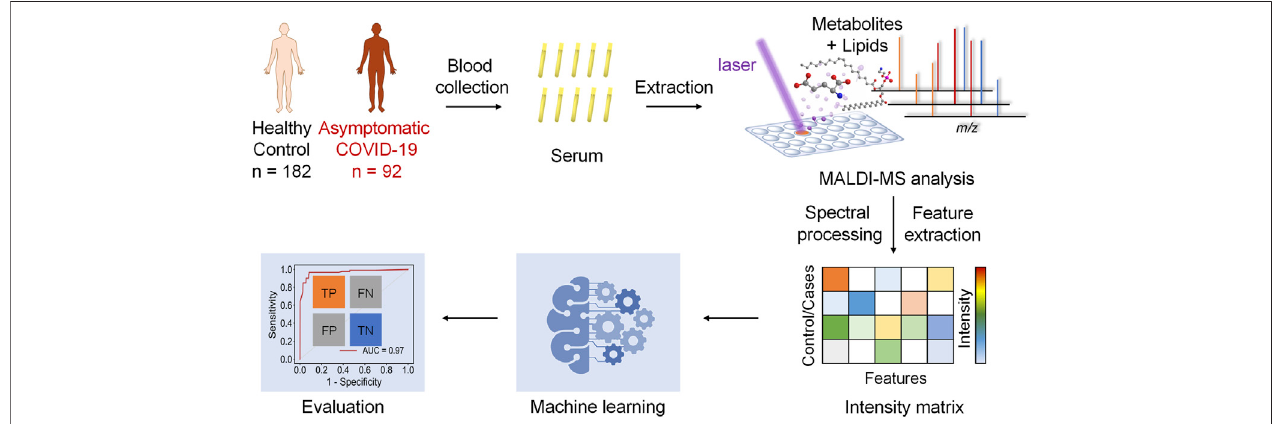
FIGURE 1 | Schematics of the MALDI-MS and machine learning-based diagnosis of asymptomatic COVID-19 patients.